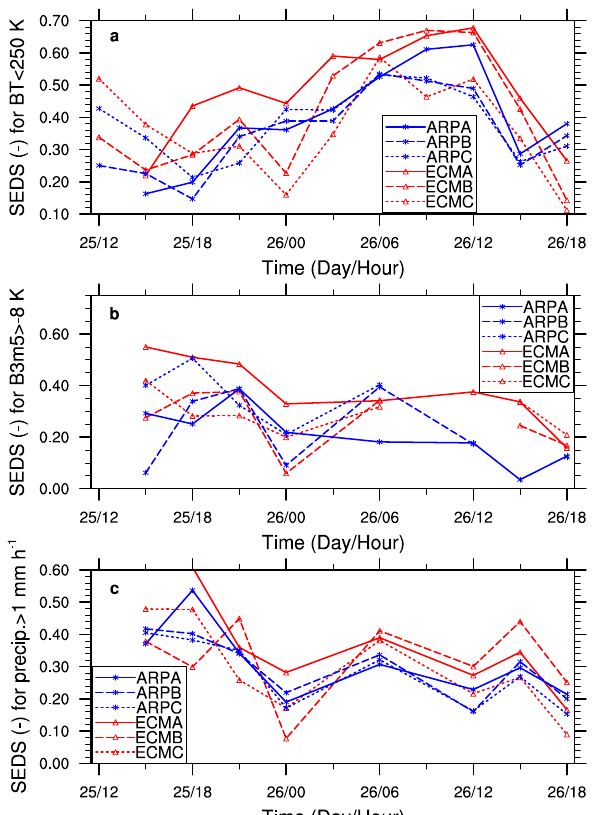
Fig. 6. Time series of spread and RMSE for (a) 10.8µm BT, (b) B3m5 and (c) instantaneous precipitation. Fields were calculated over the domain shown in Fig. 3.